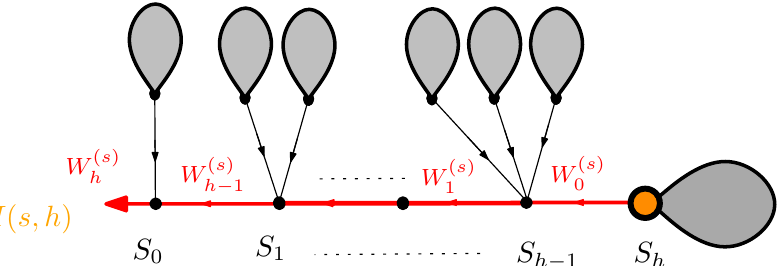
, S ) an independent unconditioned h ∞